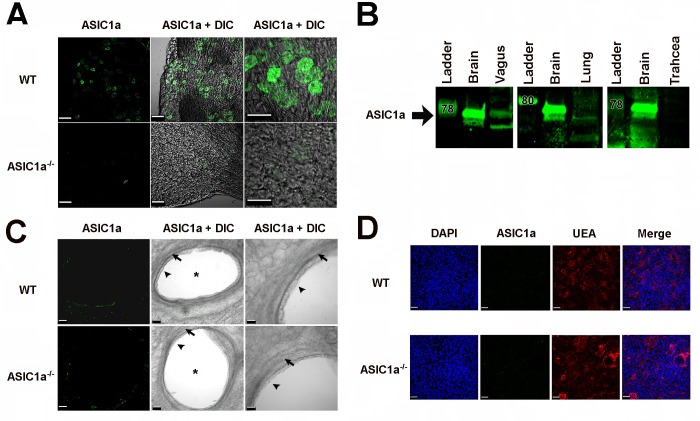
ASIC1a is present in vagal ganglia and expression in the airway is non-specific or negligible.A) Images of wild-type (WT) and ASIC1a-/- mouse vagal ganglia. ASIC1a immunostaining is in green, and DIC indicates differential interference contrast images. Scale bar in left and middle panels is 60 μm; scale bar in the right panel is 40 μm. B) Western blot of ASIC1a in the vagal ganglia. Brain is a positive control. For vagal ganglia, trachea, and lung, 40 μg of protein from tissues of 3 WT mice were pooled. For brain, 10 μg of protein was loaded. C) Images of wild-type (WT) and ASIC1a-/- mouse lung cross-sections. ASIC1a immunostaining is shown in green, and DIC indicates differential interference contrast images. Scale bar in left and middle panels is 50 μm; scale bar in the right panel is 30 μm. Asterisks indicate airways; arrowheads show epithelia; arrows identify smooth muscle. D) Images of wild-type (WT) and ASIC1a-/- mouse cultured airway epithelia. DAPI staining is blue (nuclei), ASIC1a immunostaining is in green, ulex europaeus agglutinin (UEA) staining is red (mucin-producing cells), and DIC indicates differential interference contrast images. Scale bar is 30 μm. Abbreviations: WT, wild-type; ASIC, acid-sensing ion channel; DIC, differential interference contrast. UEA, ulex europaeus agglutinin; DAPI, 4',6-diamidino-2-phenylindole. Staining of airways and cultures occurred using same procedures and same conditions as the vagal ganglia.